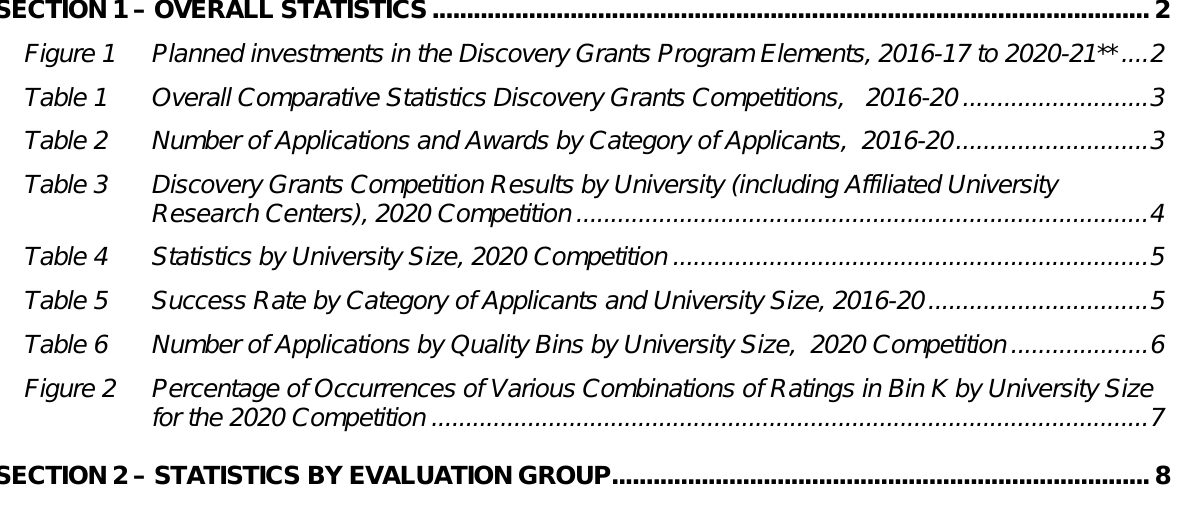
Percentage of Occurrences of Various Combinations of Ratings in Bin K by University Size